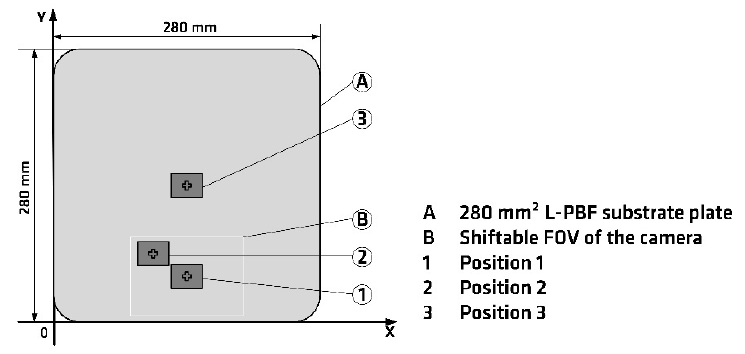
Figure 7. Positioning of the heated specimen on top of the (lowered) build plate .